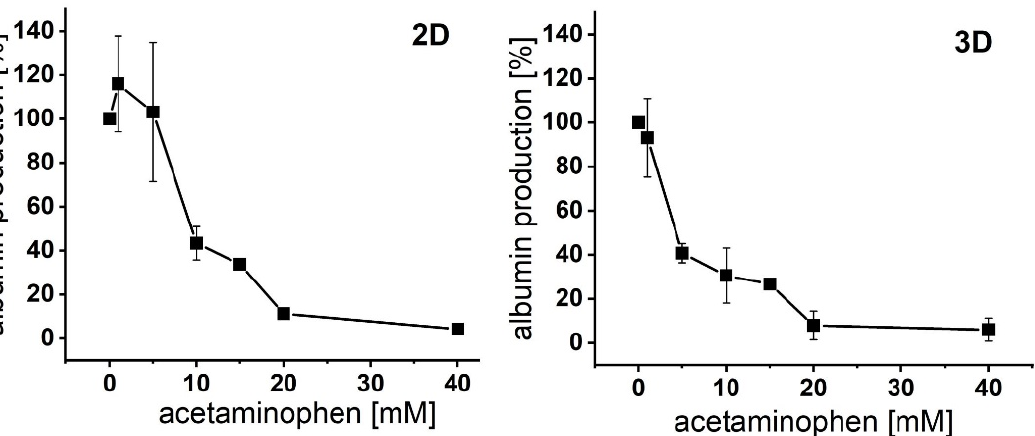
Figure 3. Concentration-dependent effect of acetaminophen on albumin production in HepaRG cells: monolayer- and MatriGrid ® -cultured HepaRG cells were incubated with increasing concentrations of APAP (0, 1, 5, 10, 15, 20, 40 mM) for 24 h. Medium was analyzed for albumin concentration with a commercial ELISA quantitation kit. Albumin levels were normalized to the total cell number (per million cells). The albumin content of cells treated only with medium (control; 0 mM APAP) was set to 100% and the albumin production of cells treated with APAP was normalized to this control. The mean values ± SE are shown; n = 3 (2D monolayer), n = 4 (3D MatriGrid ® ) experi- ments.